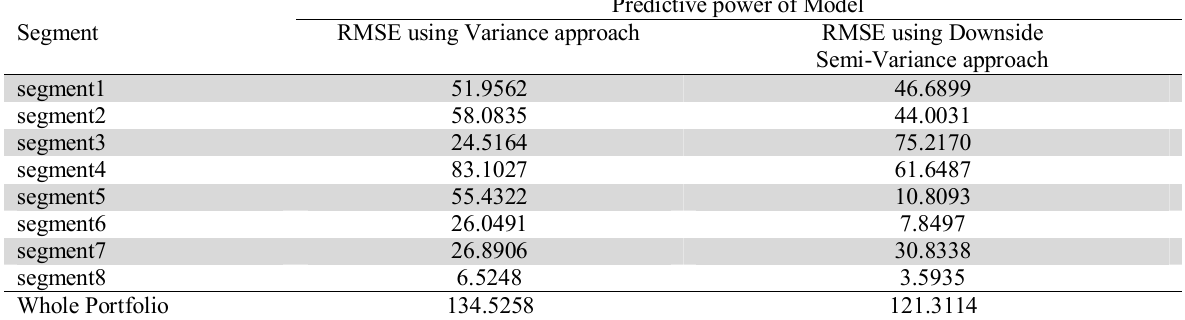
RMSE for CLV prediction by Pareto/NBD model and via different approaches of risk measurement